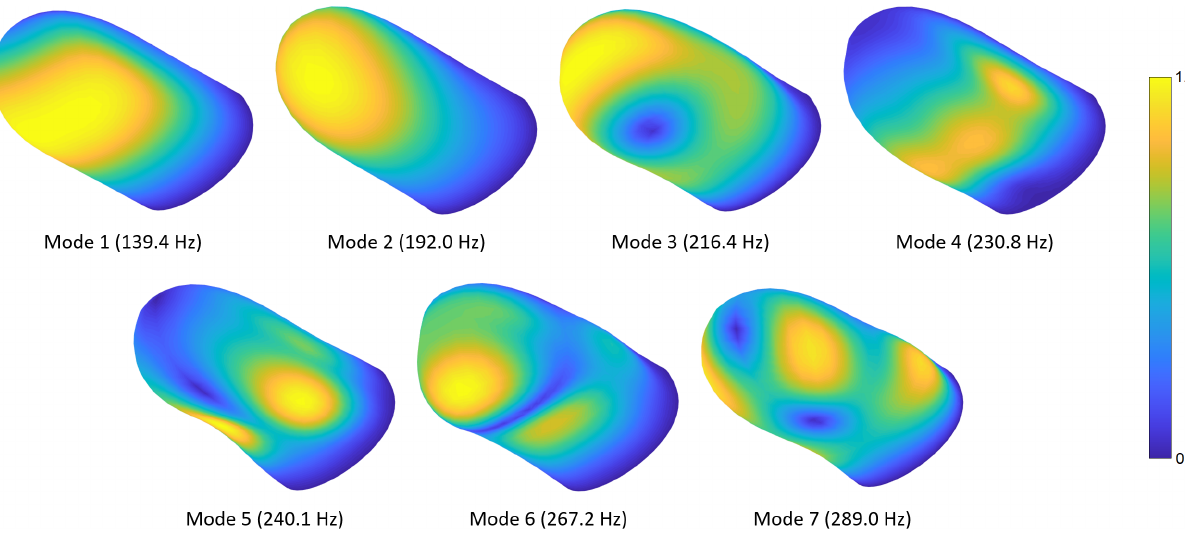
Figure A1. DigiTip’s first seven mode shapes and corresponding natural frequencies for an alternative model configuration, in which the rear boundary is entirely restrained. The contours indicate equivalent displacement magnitudes. In comparison with the results from the free boundary condition in Figure 4, the nodes along the boundary remain fixed (dark blue color), but the general shapes and the order of the seven modes do not